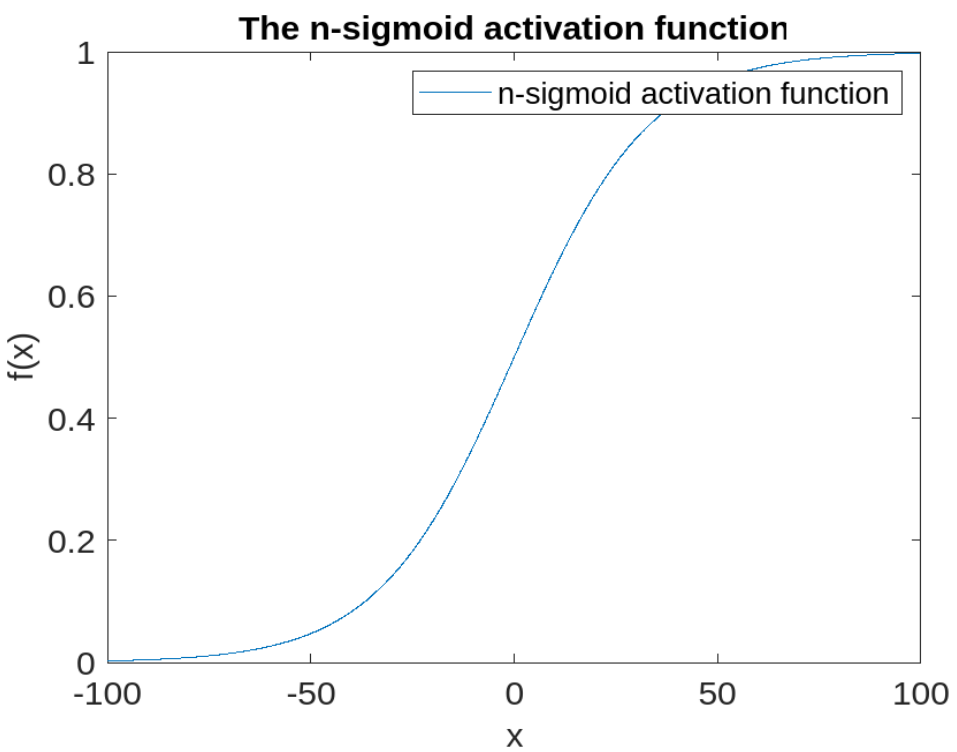
Figure 3. The n-sigmoid activation function.